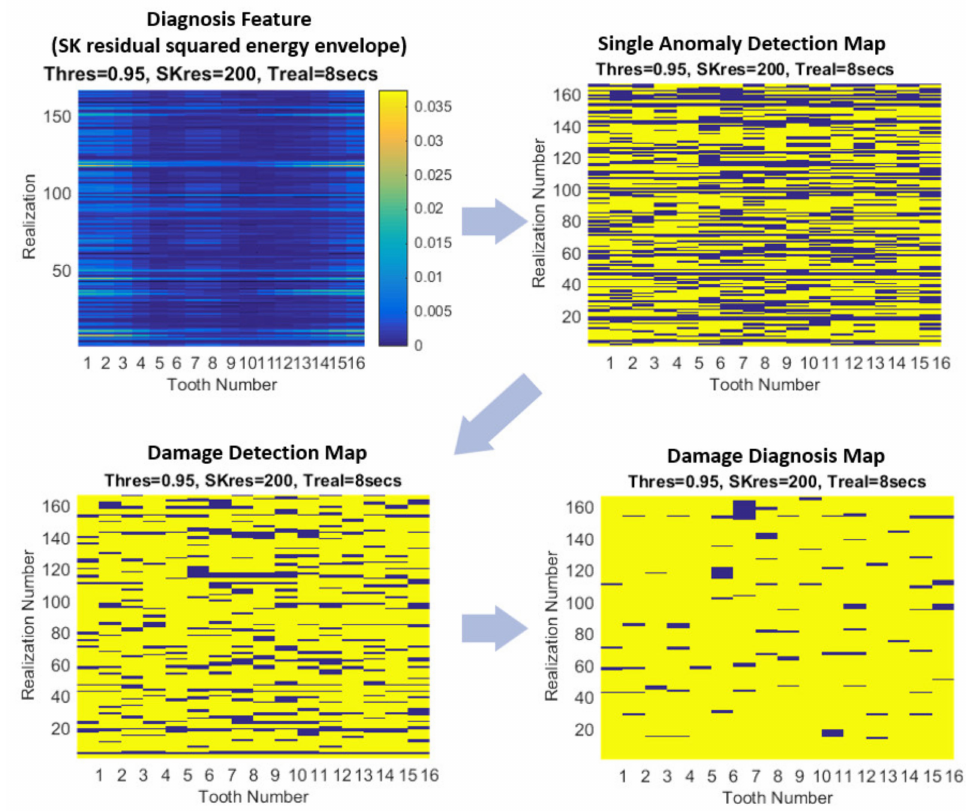
Figure 12. Example of automated damage diagnosis